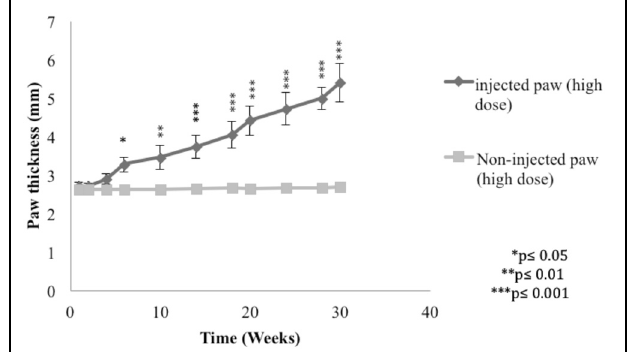
FIGURE 2 | Effect of Leishmania major infection on the paw thickness in mice infected with high dose (4 × 10 6 promastigotes/50 μ l nutrient broth medium/left hind paw). Each result is the mean of 5 mice ± SEM and the degree of significance of the difference was calculated with reference to the non-infected paw.